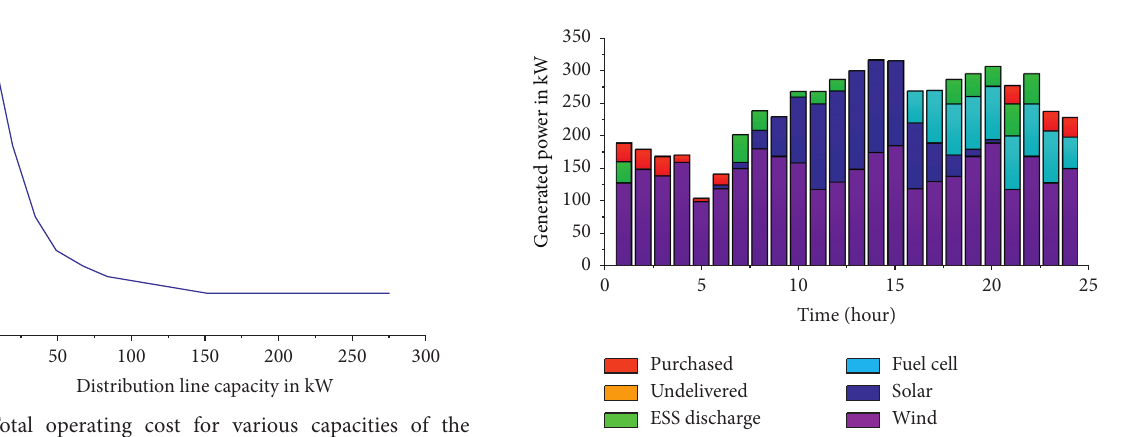
Figure 15: The optimum scheduling for various power sources and purchased power from the power market (considering the load uncertainty).